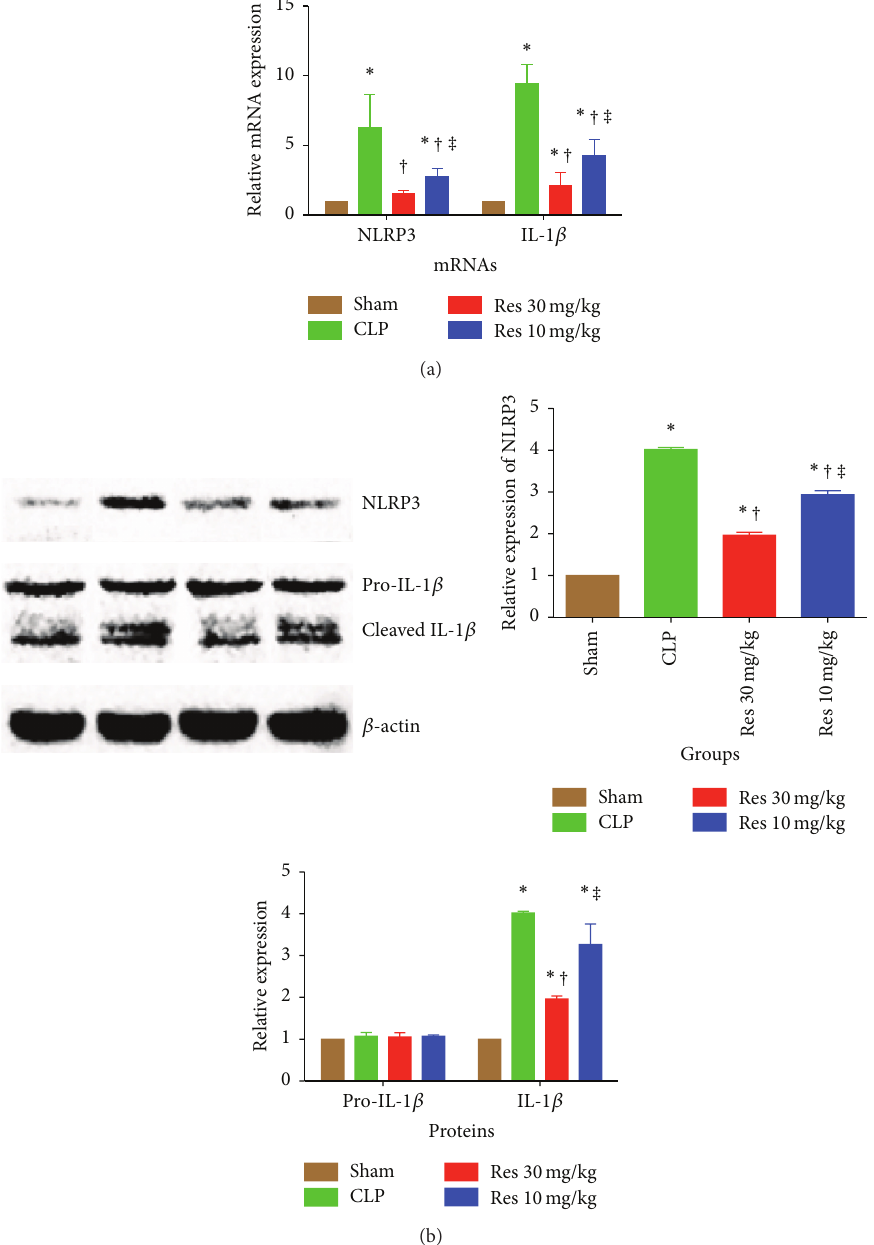
Figure 4: IL-1 𝛽 and NLRP3 inflammasome are upregulated during SAE. (a) mRNA assay of NLRP3 and IL-1 𝛽 by quantitative real-time PCR; (b) Western blot assay of NLRP3 and IL-1 𝛽 , which has been normalized to 𝛽 -actin. ∗ 𝑃 < 0.05 compared with Sham group, † 𝑃 < 0.05 compared with CLP group, and ‡ 𝑃 < 0.05 compared with Res1 group, by one-way ANOVA and LSD tests. Bars represent the mean ± SD.